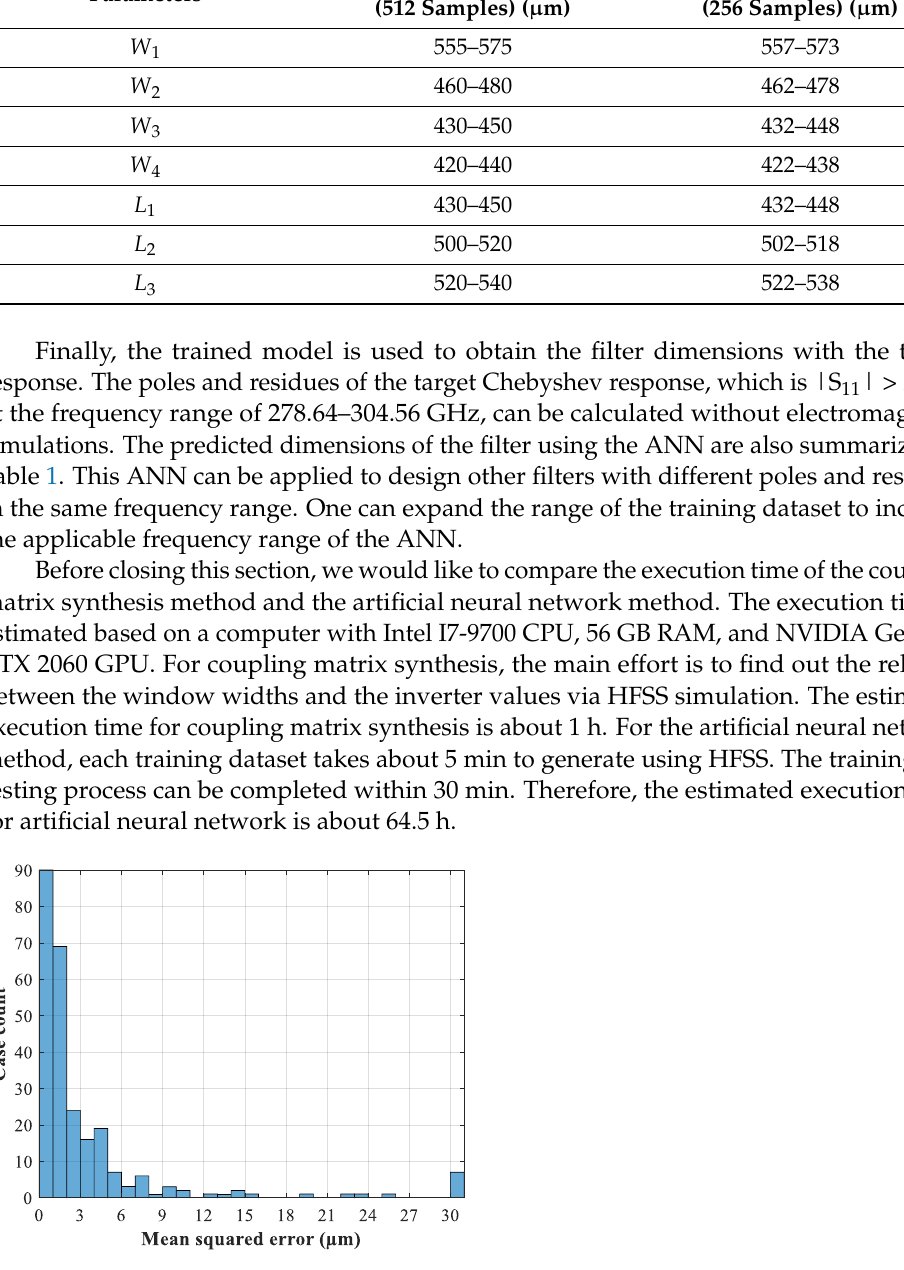
Figure 5. The histogram of the result of 256 test samples.